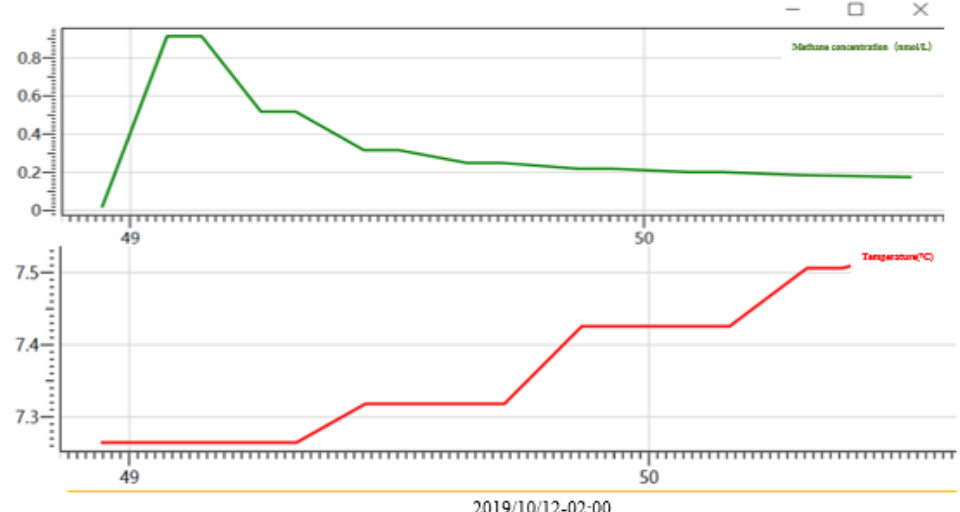
Figure 7. Test data at a water depth of 500 m (18,260–18,265 sound communication module paired successfully).